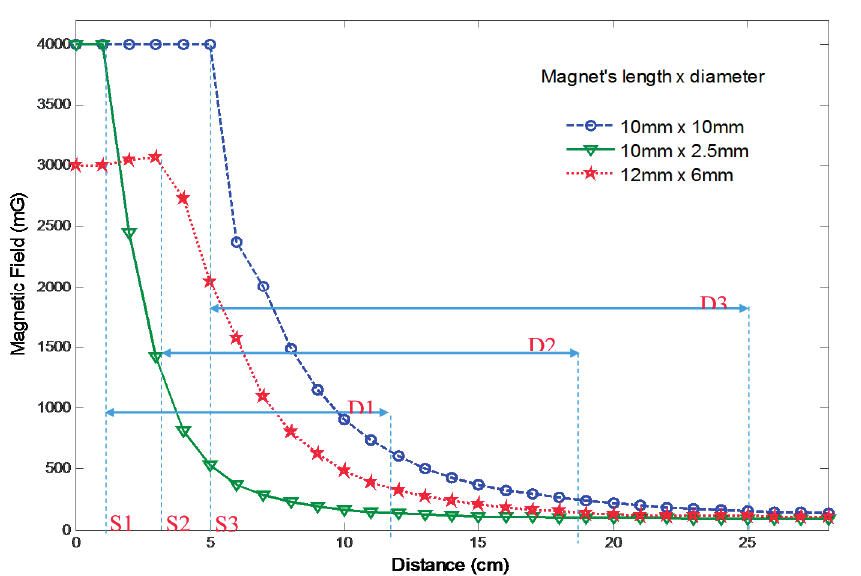
Figure 5. Characteristic curves for cylindrical magnets.